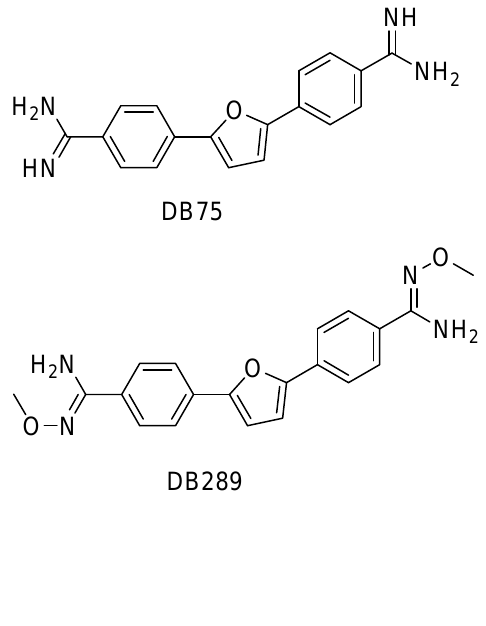
Figure 6. Chemical structures of DB75 and its prodrug DB289.